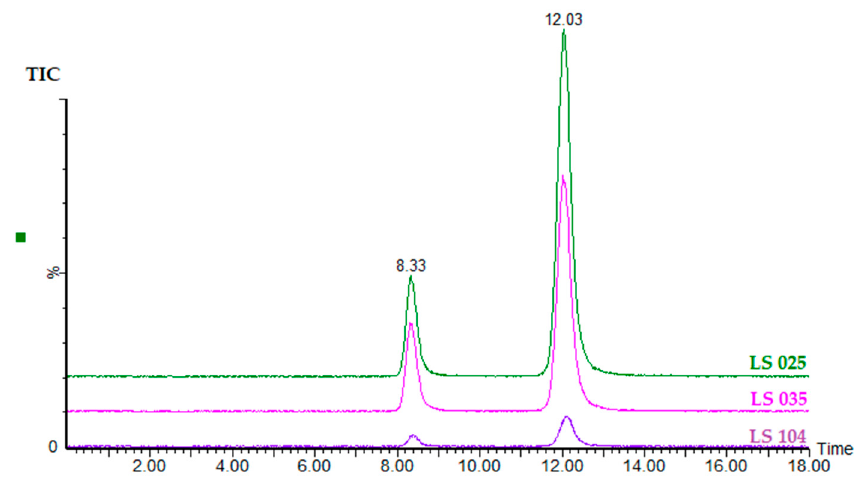
Figure 2. TIC from MRM chromatograms ( m / z 177 > 116 and m / z 177 > 87) of samples LS 104, LS 035, and LS 025.